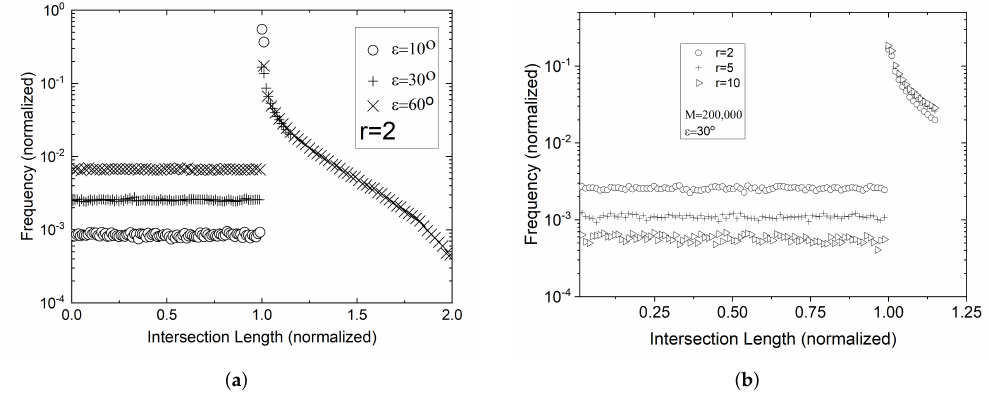
Figure 4. ( a ) Histograms of intersection lengths, normalized by dividing with the short side ( S ) of the rectangle, for flakes of aspect ratio r = 2 and three levels of (cid:101) values and ( b ) constant (cid:101) = π /6 and three values of r . In each case, the number of bins is 100. The logarithmic axis is used for the frequency of intersection lengths, since, when (cid:101) is small, the overwhelming majority of intersection lengths are ∼ S ; very few intersections have lengths less or greater than S . It is obvious that the peak occurs at H / S = 1 and also that there is no secondary peak when (cid:101) < π /2. In each case, 2 × 10 5 random pairs of ( L , θ ) were used in obtaining the histograms. It is also clear from ( b ) that max ( H ) is independent of r , and from ( a ) it is evident that max ( H ) is a function of (cid:101)